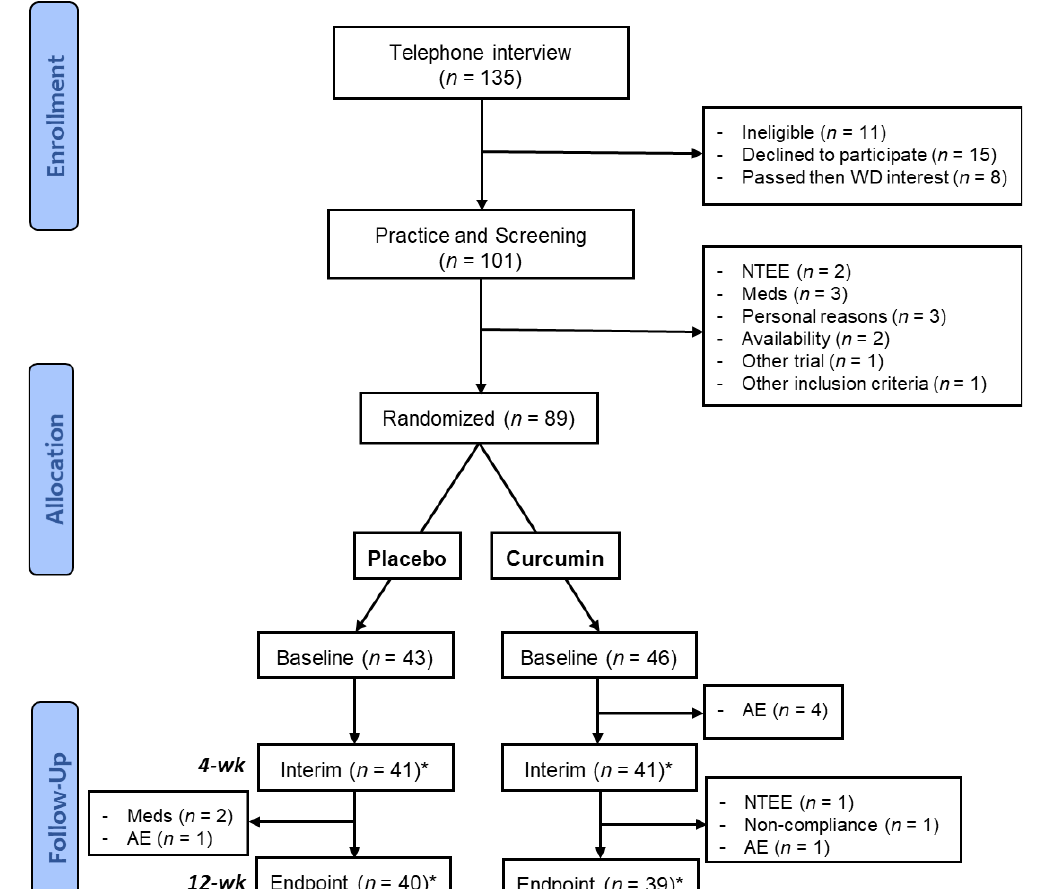
Figure 1. Modified Consort diagram showing participant recruitment and flow through the trial. Key: WD, withdrew; NTEE, Non-treatment emergent event (adverse event with onset prior to commencement of the trial intervention); Meds, use of medication listed in exclusion criteria; AE, adverse event; * Three participants (2 × Placebo, 1 × Curcumin) did not complete the Interim visit but did complete the Endpoint visit.